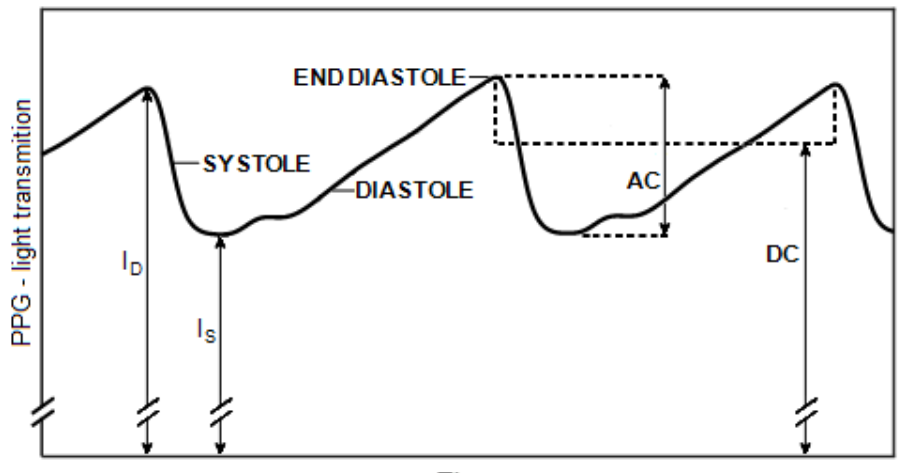
Figure 2. The PPG pulses—the transmitted light through the tissue as a function of time. The PPG signal decreases during systole, when blood enters the tissue, and increases during diastole. AC is the peak-to-peak amplitude—the difference between the maximum and minimum of the PPG pulse. DC is the mean light transmission throughout the PPG pulse. I D , I S —the transmitted light intensity at the maximum and the minimum of the PPG pulse, respectively.